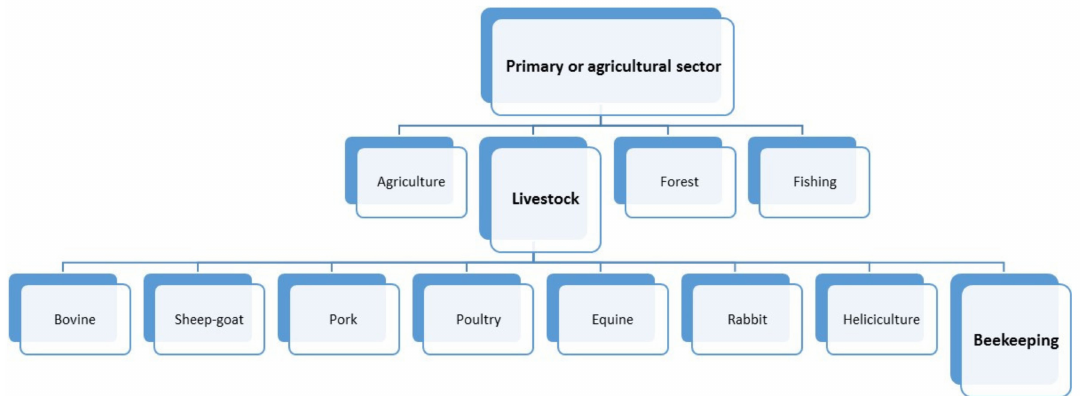
Figure 1. Beekeeping sector. Source: Own elaboration.